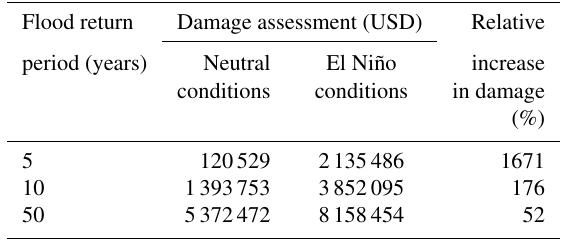
Table 4. Flood damage and expected increases during El Niño con-